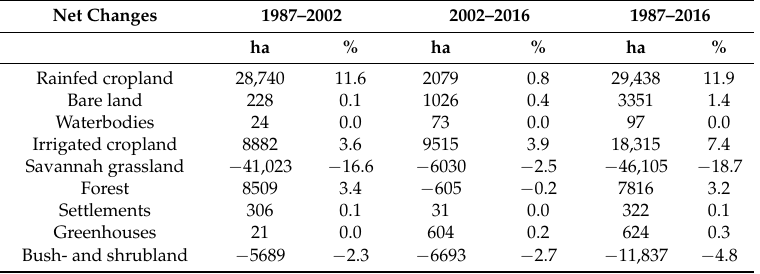
Table 2. Net area changes for each land cover and land use class within the study area in hectares (ha) and percent (%) of the total area analyzed between 1987 and 2002, between 2002 and 2016, and across the entire time interval from 1987 to